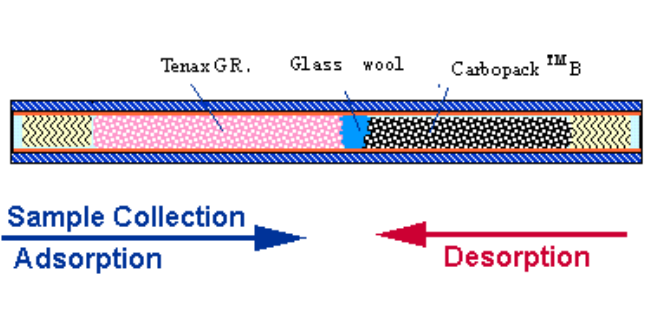
Figure 2. Multi-bed sorbent